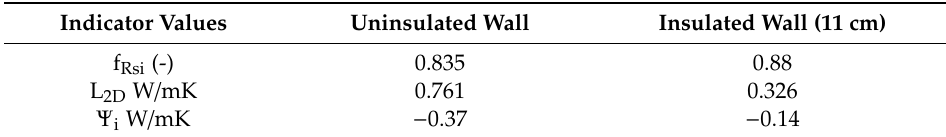
Table 7. Comparison of calculation